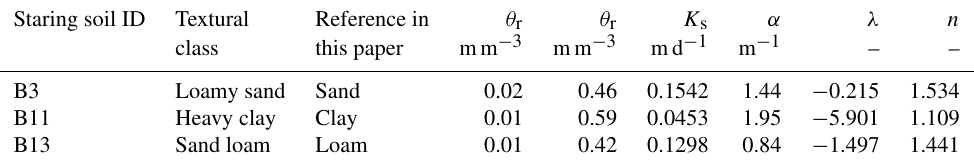
Table 3. Mualem–van Genuchten parameters for three soils of the Dutch Staring series (Wösten et al., 1999) used in simulations. θ s and θ r are the saturated and residual water content, respectively; K s is saturated hydraulic conductivity and α , λ , and n are fitting parameters. Staring soil ID Textural